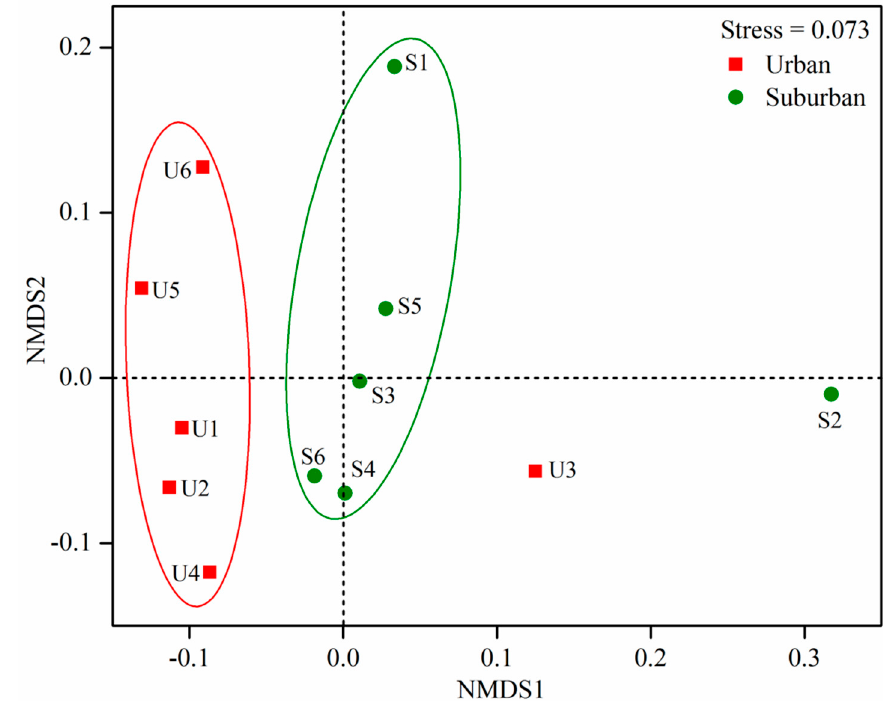
Figure 4. Nonmetric multidimensional scaling (NMDS) ordination of the dissimilarity (Bray-Curtis distance) in bacterial community composition. Table 3. Summary of Pearson’s correlation analysis between chemical properties and bacterial richness and diversity indexes. Environmental